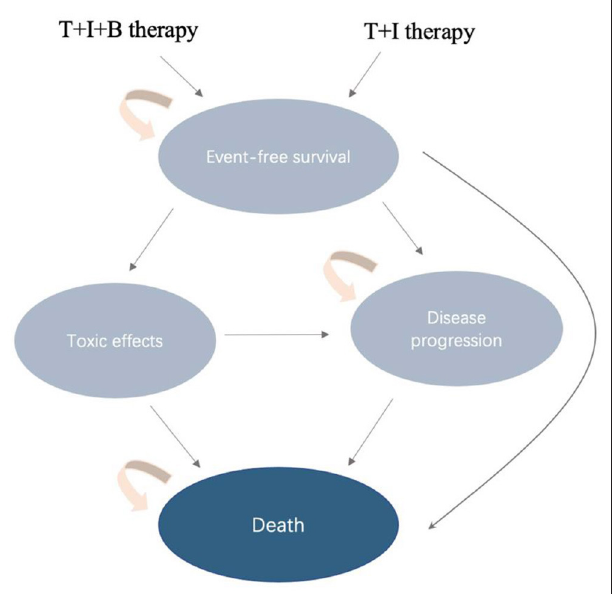
FIGURE 1 | Diagram of transitions between health